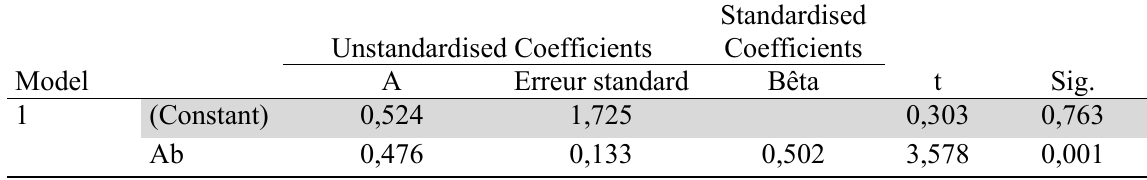
Coefficients a (Relation Ab → PI)